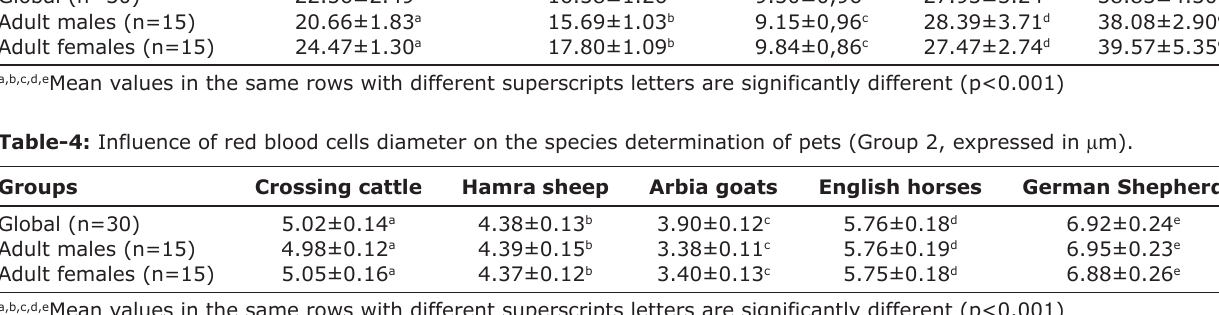
Table-3: Influence of red blood cells surface on the species determination of pets (Group 1, expressed in μ m 2 ). Groups